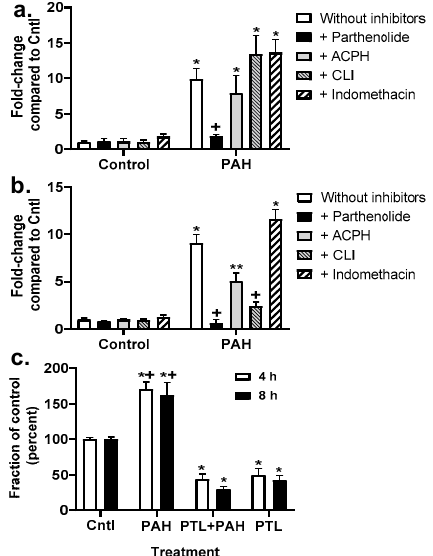
Figure 6. KC transcript and protein levels are elevated in response to LMW PAHs and inhibited in the presence of PTL. Kc transcript levels in C10 ( a ) and E10 ( b ) cells in response to 4 h PAH exposure (40 µ M 1:1 ratio of 1-methylanthracene and fluoranthene) ± inhibitors. For ( a , b ), * p < 0.05 for treatment compared to control (DMSO); + p < 0.05 for PTL or CLI + PAH compared to PAH without inhibitors; ** p < 0.05 for ACHP + PAH compared to PAH without inhibitors. Experiments repeated 2–3 times with an n = 3 per treatment. ( c ) KC proteins levels were measured (ELISA) at 4 and 8 h following PAH mixture in C10 cells ± PTL (parthenolide) (10 µ M). Experiments repeated 3 times with an n = 3 per treatment per experiment. Cancers 2019 , 11 , x